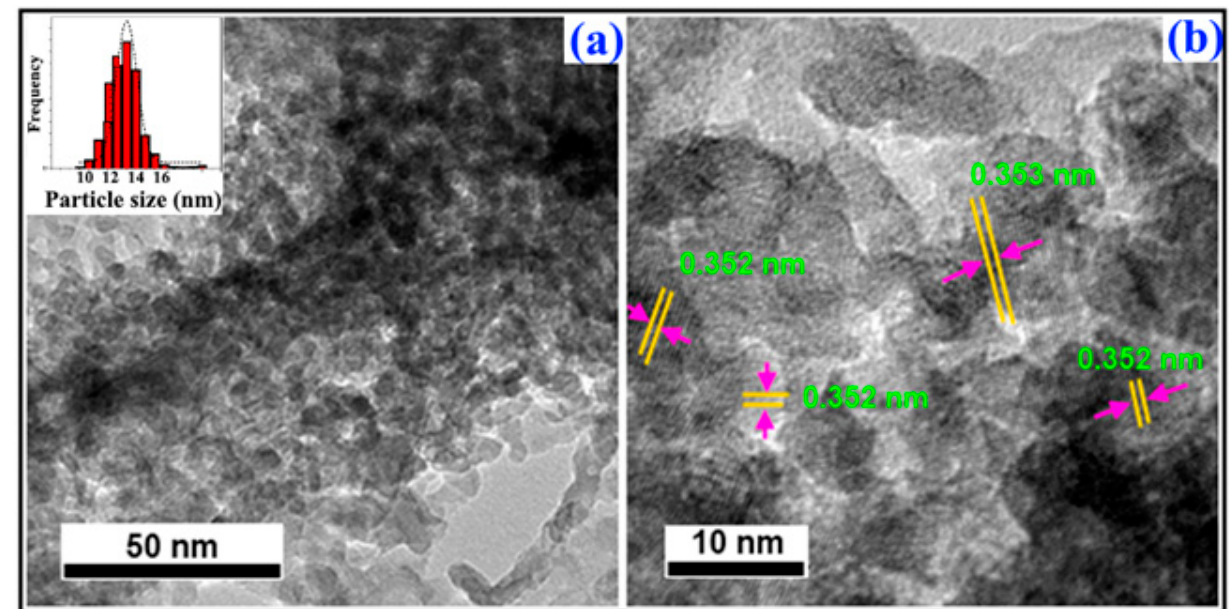
Figure 3. TEM ( a ) and HRTEM ( b ) images of TiO 2 nanoparticles coated FA cenospheres. The inset presents the particle size distribution of the nanomaterials.